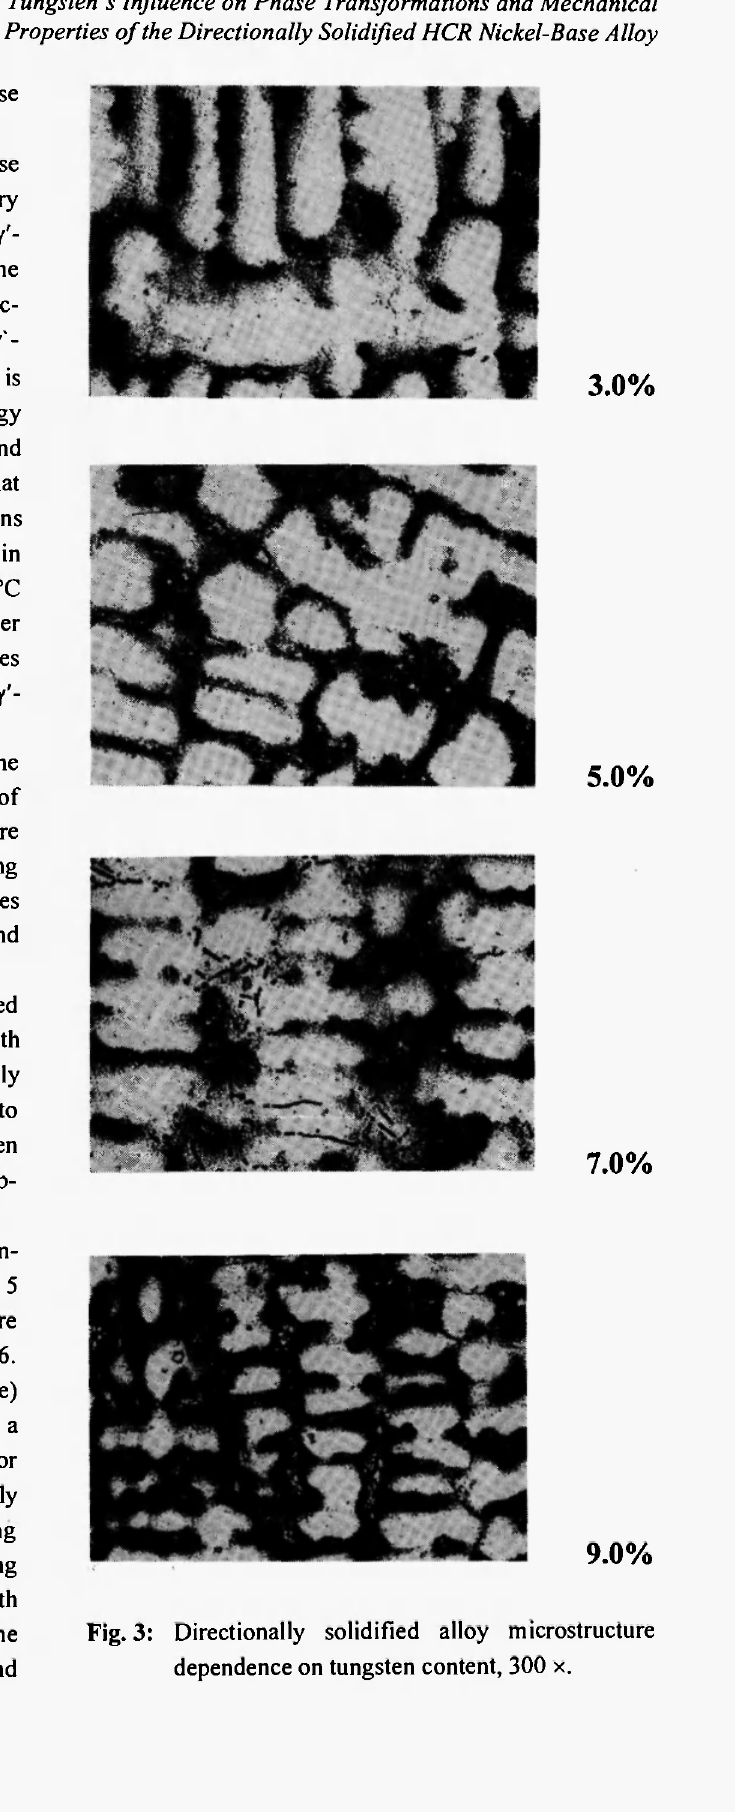
Fig. 3: Directionally solidified alloy microstructure dependence on tungsten content, 300